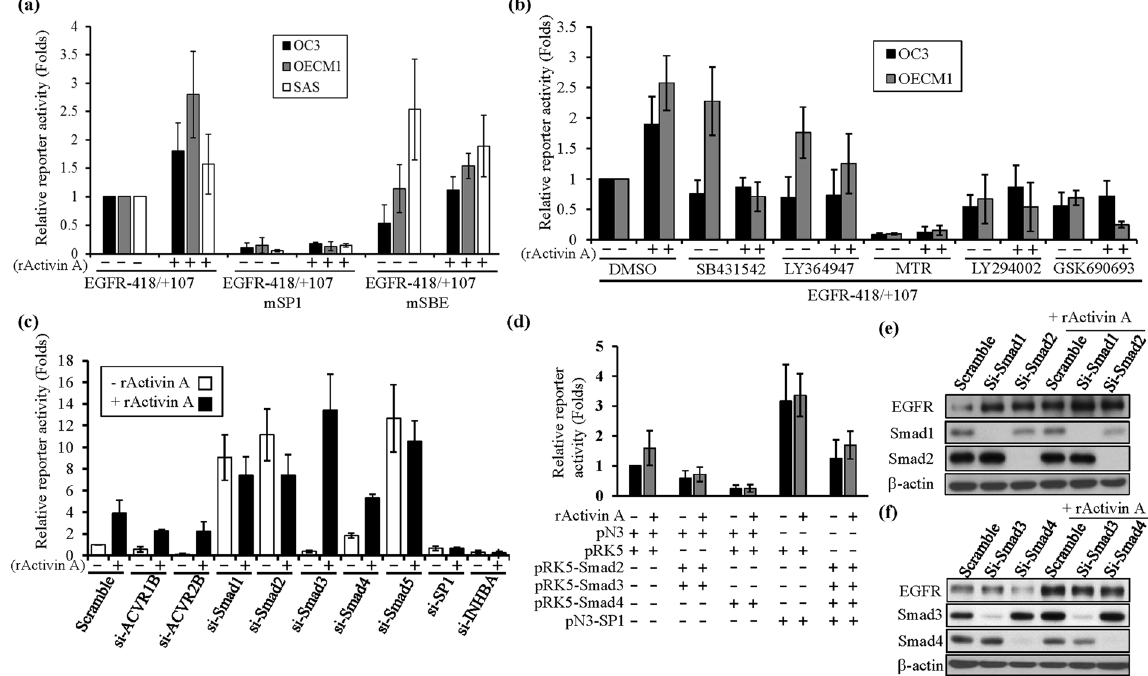
Figure 4. The SP1 and Smad transcription factors were crucial for rActivin-mediated regulation of the EGFR promoter as measured using a luciferase reporter assay. ( a ) Luciferase reporters were transfected into OC3, OECM1 and SAS cells with or without rActivin A treatment. All luciferase activity was normalized to Renilla reporter activity. The normalized reporter activity in cells transfected with EGFR-418/ + 107 without rActivin treatment (control) was considered onefold, and the relative fold for each construct (mSP1 or mSBE) with or without rActivin A treatment was further normalized to that of the control. ( b ) Reporters were transfected into OECM1 and OC3 cells with or without rActivin versus treatment with SB431542, Mithramycin, LY294002 and GSK690693. The normalized reporter activity in cells transfected with EGFR-418/ + 107 without rActivin treatment (DMSO, vehicle) was considered onefold, and the relative fold of each treatment was calculated. ( c ) The EGFR-408/ + 107 luciferase reporter was cotransfected with scramble, si- INHBA , si- SP1 , si- ALK4 , si- ACVR2B , si-Smad1 , si- Smad2 , si- Smad3 , si- Smad4 or si-Smad5 in OECM1 cells treated with or without rActivin A. The normalized reporter activity in cells transfected with EGFR-418/ + 107 without rActivin treatment was considered onefold, and the relative fold of each transfection was calculated. ( d ) The EGFR promoter (EGFR- 408/ + 107) was cotransfected with vectors (pN3 and pRK5), pRK5-Smads, or pN3-SP1 in the presence or absence of rActivin A in OC3 cells. The normalized reporter activity in cells transfected with EGFR-418/ + 107 and vectors (pN3 and pKR5) without rActivin treatment was considered onefold, and the relative fold of each transfection was calculated. ( e , f ) Protein expression of EGFR, Smad1, Smad2, Smad3, Smad4 and SP1 was examined in scramble- and siRNA-transfected OC3 cells via western blotting. Expression of β -actin was used as an internal control. The complete medium was changed to serum-free conditions 24 hr after transfection, and cells were treated with rActivin A for 24 hr before harvesting. Each luciferase experiment is presented as the average of three to five individual